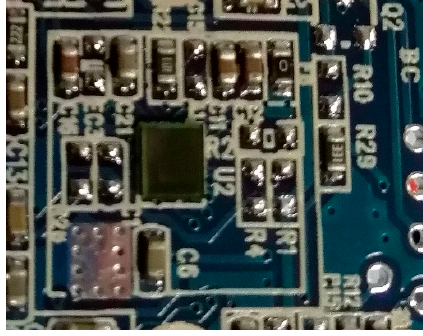
Figure 8. Physical prototype of a fingerprint sensor based on electrostatic imaging.